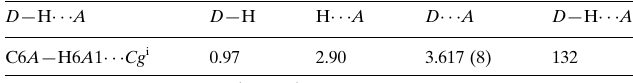
Hydrogen-bond geometry (A˚ , (cid:2)